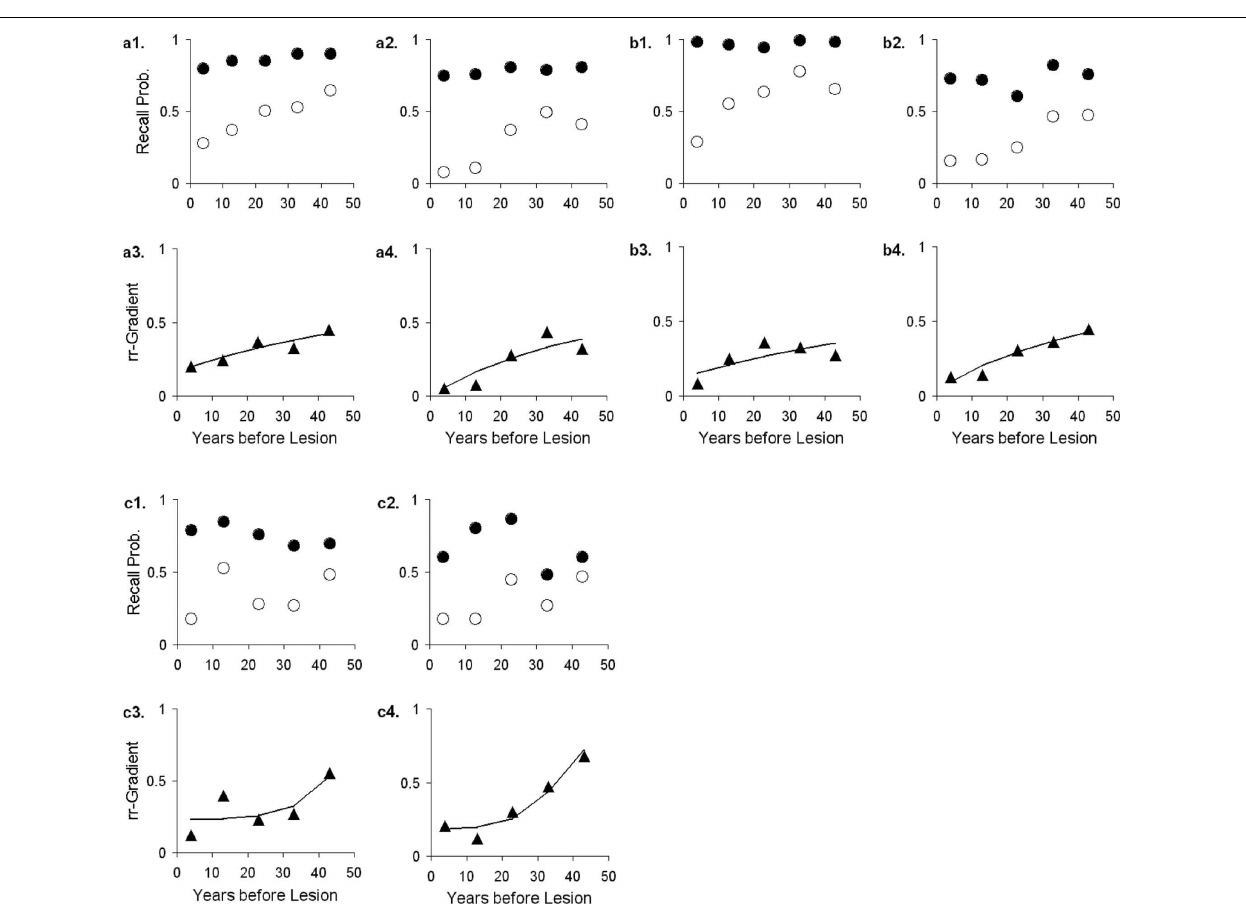
patient data, solid circles controls. Panels 3 and 4 give the relative retrograde gradient for easy and hard items, respectively, shown with triangles.The solid curves are fits by the model, assuming that a 2 =